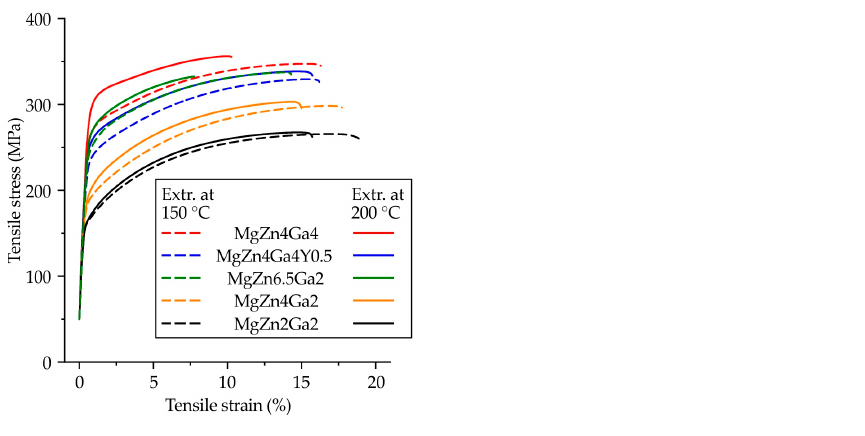
Figure 10. Engineering tensile stress–strain curves for the Mg–Zn–Ga–(Y) alloys extruded at 200 or 150 °C.